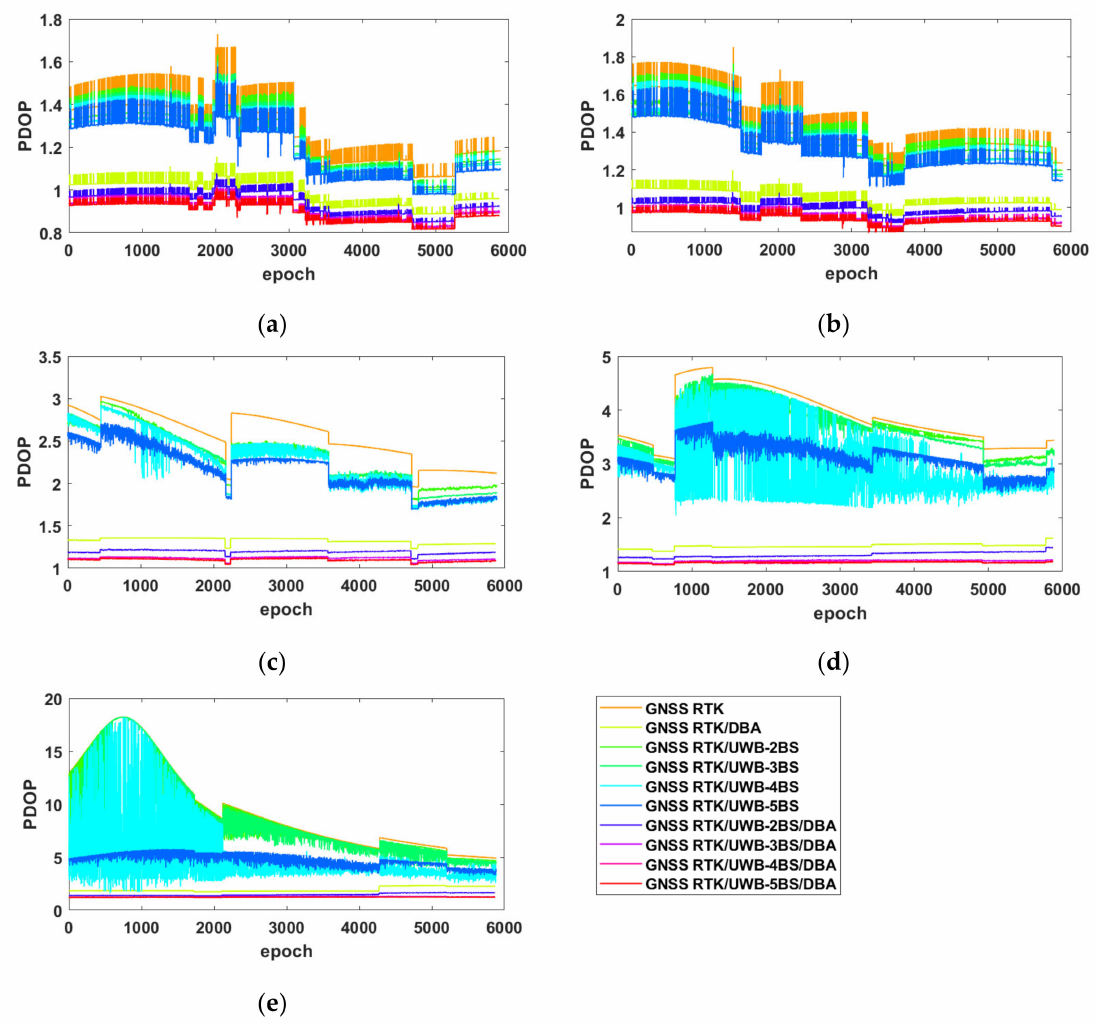
Figure 6. The PDOP values for the GNSS RTK/UWB/DBA fusion positioning model for vari- ous elevation mask angles in a static environment. The elevation mask angles were as follows: ( a ) 10 degrees; ( b ) 20 degrees; ( c ) 30 degrees; ( d ) 40 degrees; ( e ) 50